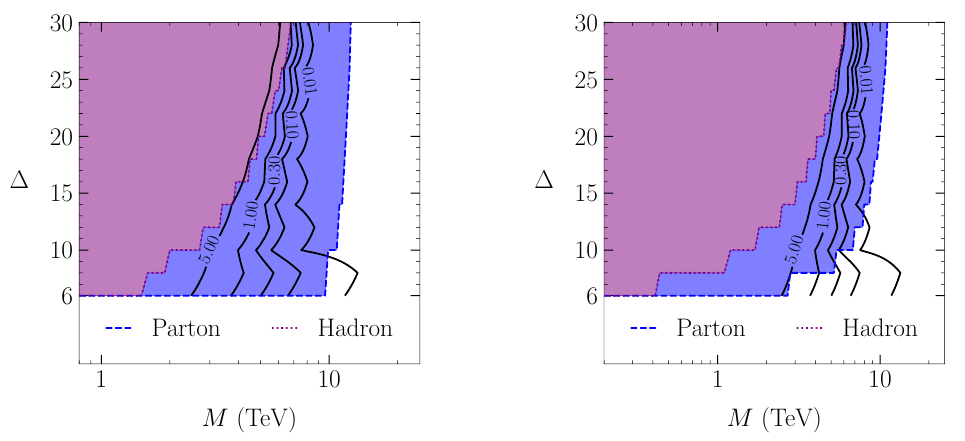
Figure 14 . A comparison of the perturbative unitarity results against the t -channel cross section predictions for two choices of the UV parameters: λ qφ = 8 π [left] and λ qφ = 2 [right]. The shaded regions are the perturbative unitarity bounds. The contours show constant power counting uncertainty. This provides evidence that valid EFTs exist in the region excluded by the naive partonic perturbative unitarity